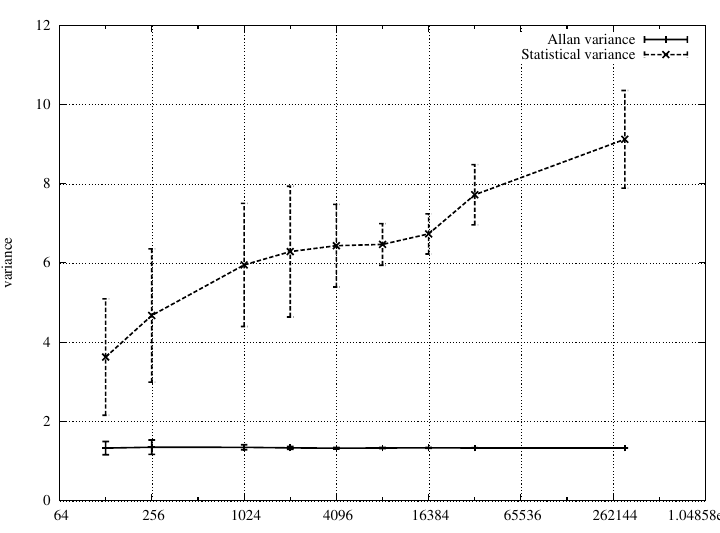
Figure 6: Dependence of the statistical variance and Allan variance on the number of measurements M